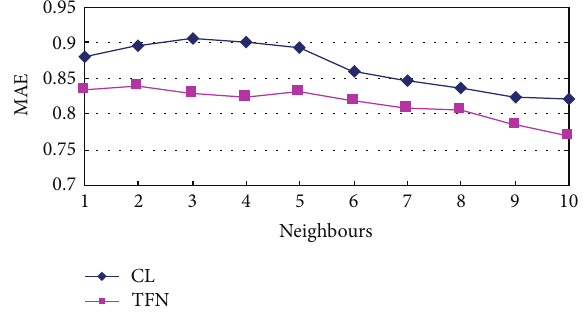
Figure 4: MAE based on CL and